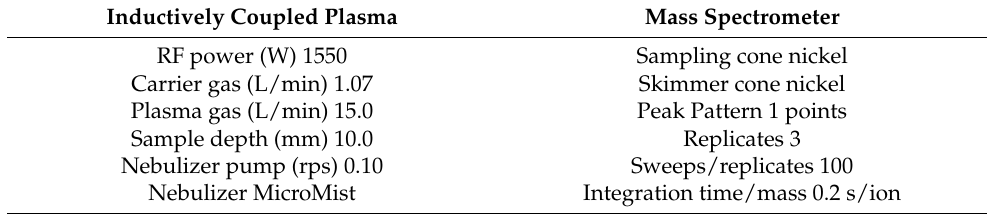
Table 2. Parameters of the